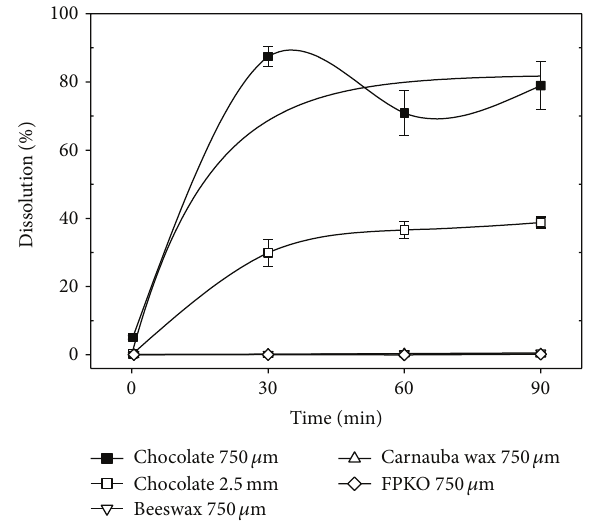
Figure 1: Effect of the matrix and particle size on dissolution in the simulated gastric solution (GS). Results are the average of three independent assays. Error bars represent Standard Error of the Means (SEM).